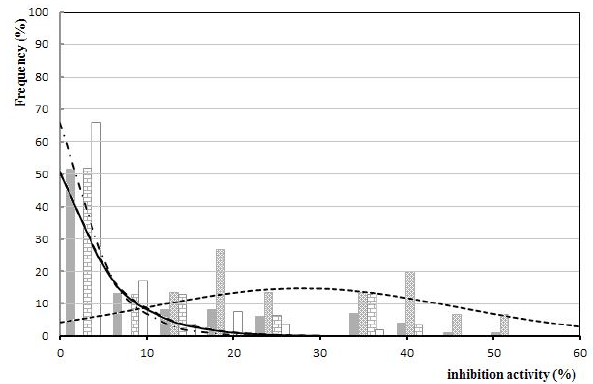
Figure 9: Distribution of inhibitory activity to trypsin of oat extracts expressed as % of inhibitory activity (solid column and solid line – complete set, r 2 = 0.923, bracket column and dash line – minor red subset, r 2 = 0.286, dots column and dash-and-dot line – major green subset, r 2 = 0.875, empty column and dots line – major blue subset, r 2 = 0.984, the mentioned colors correspond to the colors in Fig. 7 and Fig. 8).